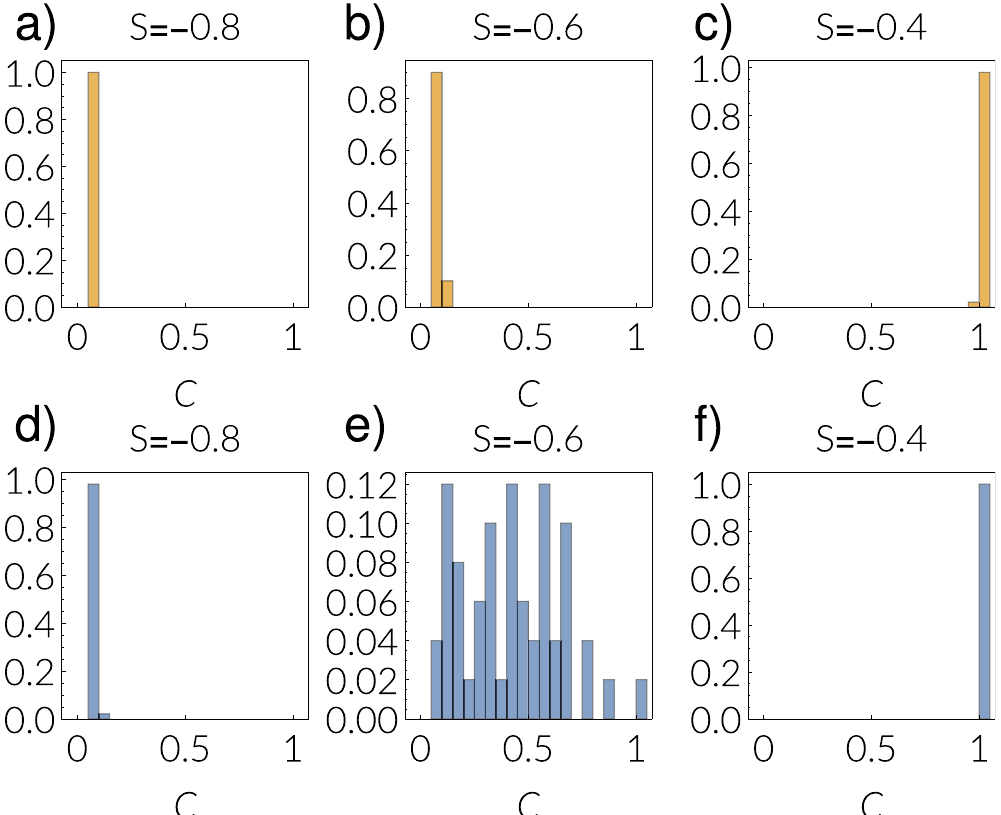
Figure 5. Distribution of final cooperation (after 5 × 10 5 rounds) in the game layer among 50 realizations of our model. The parameters are γ = 0.2 and β = 0.7, N = 10000 nodes, and mean degree 〈 k 〉 ≈ 6. Network layers have a power-law exponent of 2.9 and temperature T GMM = 0.4. Here, we have fixed T = 0.6. Plots ( a – c ) show the uncorrelated case ( g = v = 0) and ( d – f ) show the case of angular correlations ( g = 1, v = 0). The value of S is shown in the respective plot